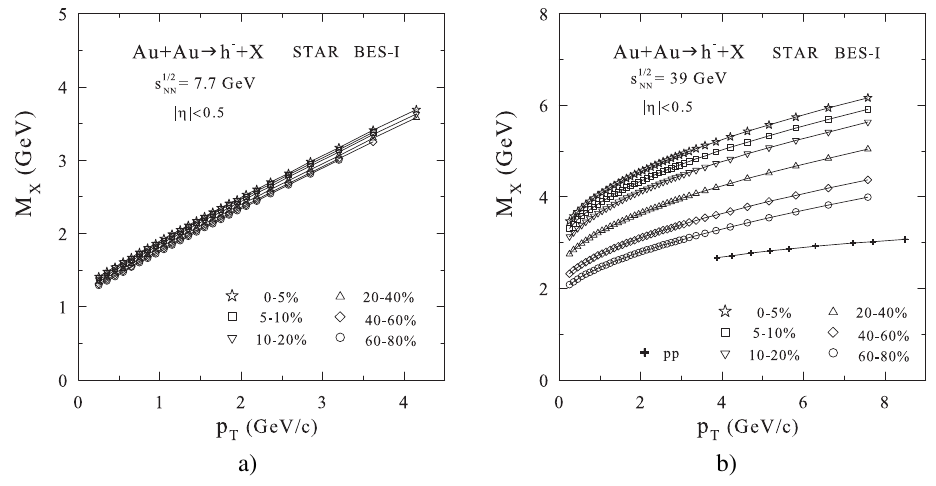
Figure 5. The dependence of the recoil mass M X on the transverse momentum p T of h − hadron produced in Au + Au collisions at the energy and | η | < 0 .